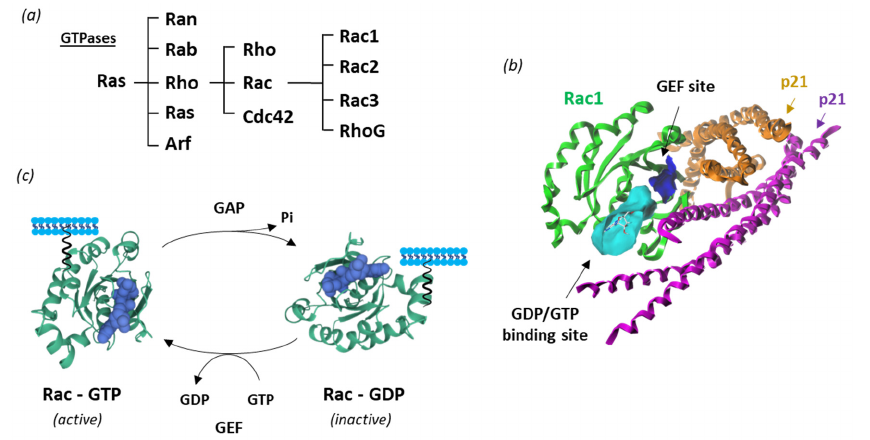
Figure 2. Rac1 structure and activity. ( a ) Classification of Ras GTPases. ( b ) A molecular model of Rac1 interacting with p21 (arfaptin) (PDB: 1I4D) with the GTP/GDP (cyan) and GEF (blue) binding